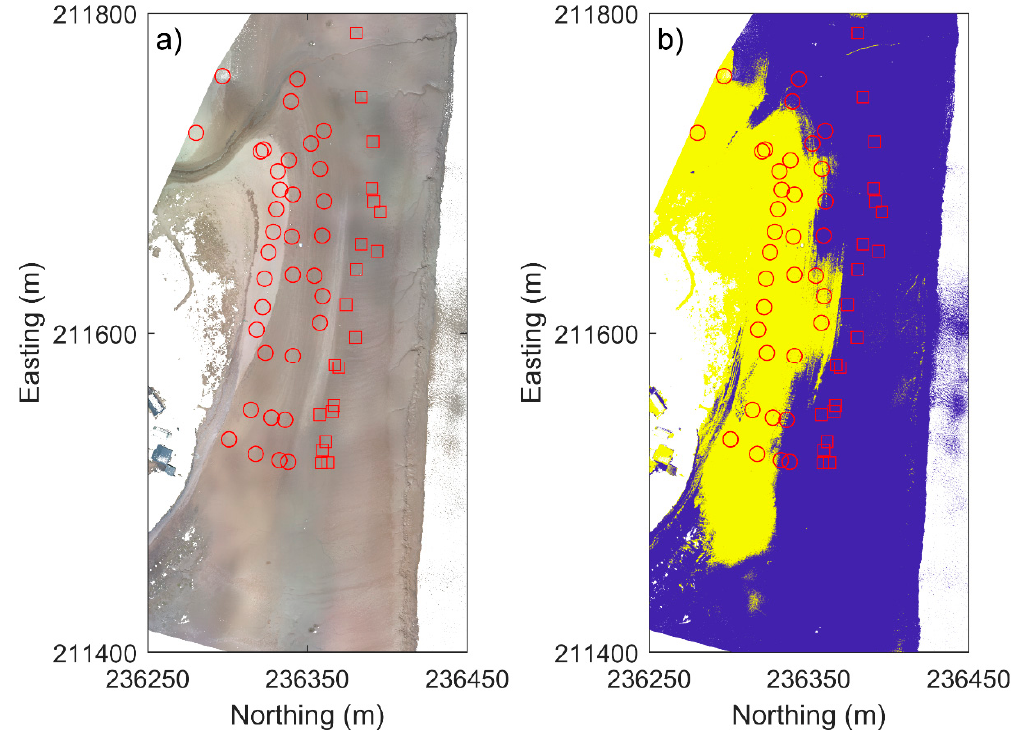
Figure 13. The Llansteffan orthomosaic ( left ) and sediment classification ( right ) with visual sediment classification marked in red (circles sand; squares mud). Yellow indicates sand classification and blue mud.